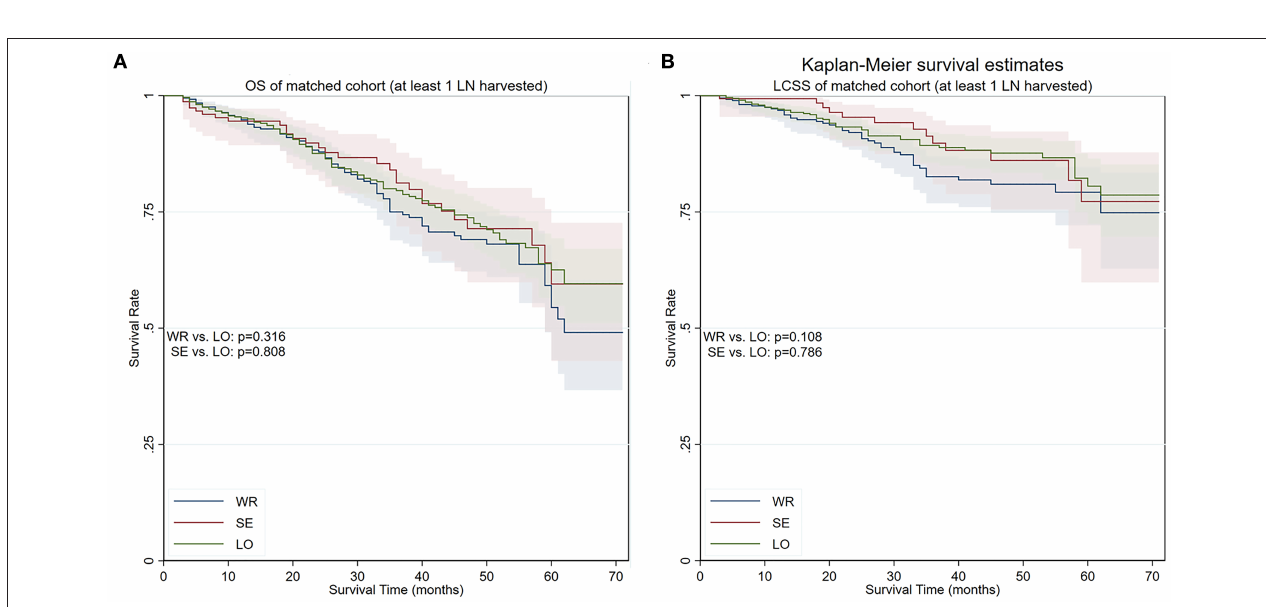
FIGURE 5 | OS and LCSS of PS-matched patients with at least one lymph node detected during the procedure. (A) OS of PS-matched patients with at least one lymph node detected during the procedure. (B) LCSS of PS-matched patients with at least one lymph node detected during the procedure. OS, overall survival; LCSS, lung cancer–specific survival; PS, propensity score; WR, wedge resection; SE, segmentectomy; LO, lobectomy.